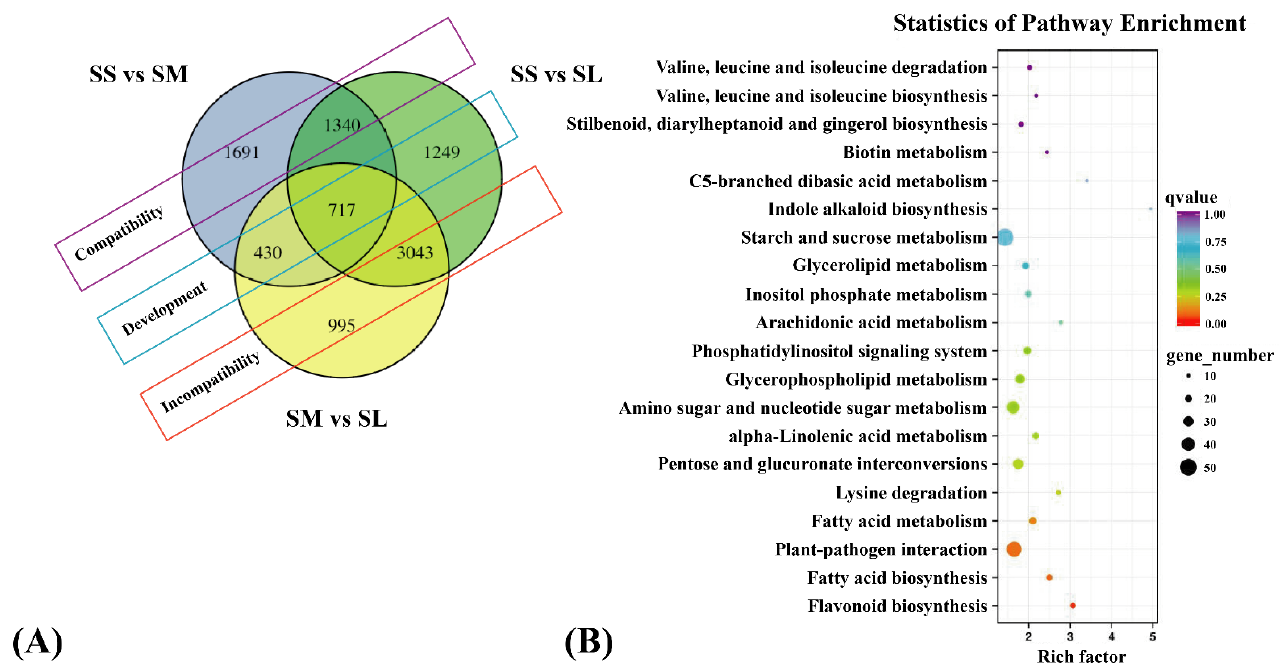
Figure 5. Functional division and KEGG analysis of DEGs. ( A ) Functional division of DEGs in the three comparison groups. The purple wire frame represents the differential gene in the compatibility groupt; the blue wire frame represents the differential gene in the developmental group; the red wire frame represents the differential gene in the “ incompatibility ” group. ( B ) KEGG enrichment analysis of DEGs in the “ incompatibility ” group.